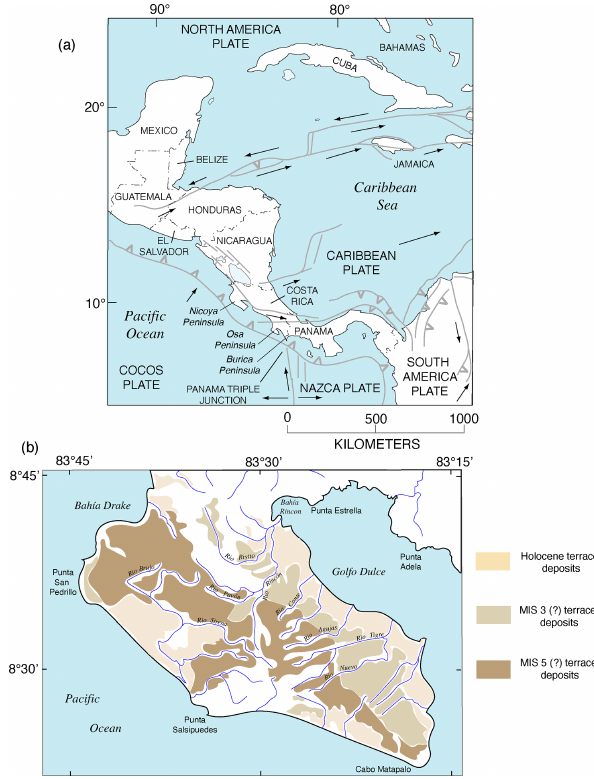
Figure 35. (a) Map of Central America, showing structural features (redrawn from Mann, 2007, and Pindell and Kennan, 2009), litho- spheric plates, directions of present plate movements (arrows), and localities referred to in text. (b) Map showing marine terrace de- posits on the Osa Peninsula of Costa Rica (redrawn from Gardner et al., 2013); legend shows possible correlation to marine isotope stages